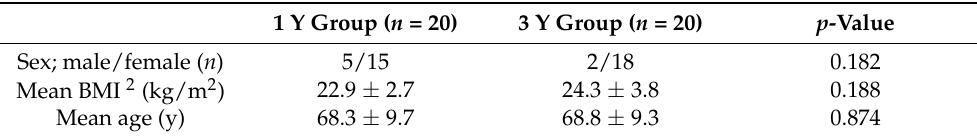
Table 1. Baseline data 1 of the two